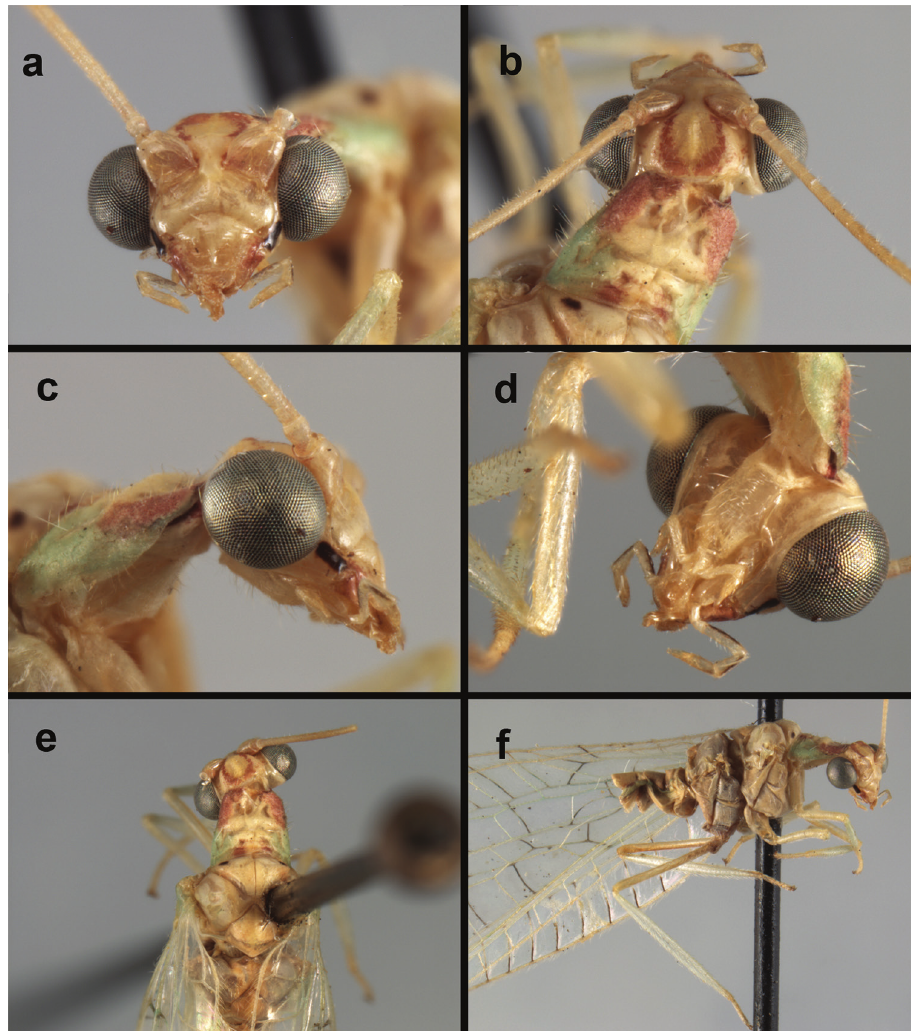
Figure 61. Ungla mexicana Tauber, sp. n. External features, ( a ) head, frontal ( b ) head, prothorax, dorsal ( c ) head, prothorax, lateral ( d ) head, ventrolateral ( e ) head, thorax, dorsal ( f ) head, thorax, lateral (Mexico, Chiapas, holotype, female, CAS) . ments: head width: 1.4 mm; ratio head width : eye width: 2.3: 1; prothorax width: 1.0 mm, length: 0.8